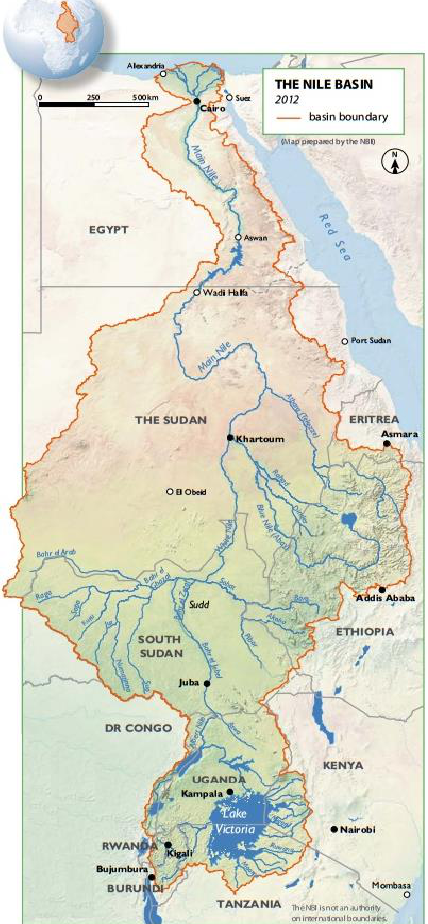
Figure 1. The Nile River Basin (NBI [43]) .